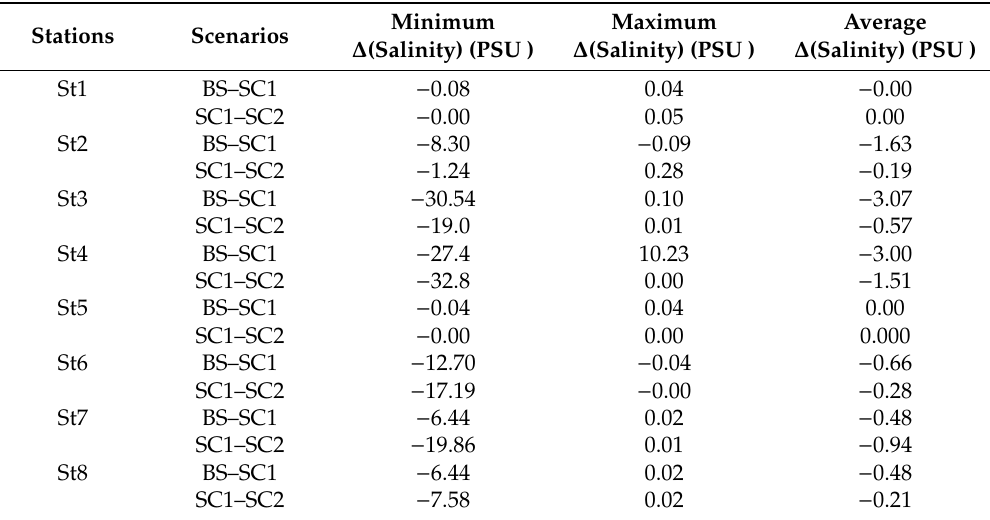
Table 4. Salinity di ff erence, ∆ (Salinity), metrics for BS–SC1 and SC1–SC2, and the lagoon